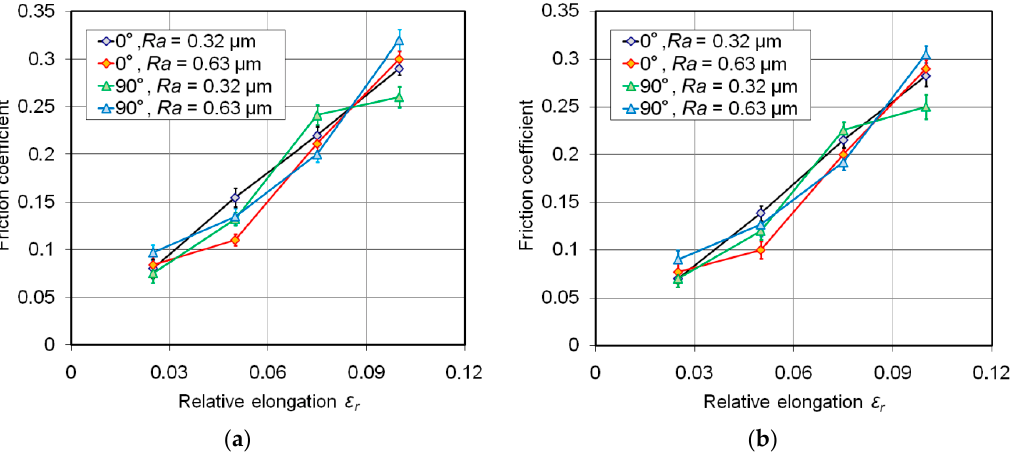
Figure 6. Effect of the relative elongation ε r on the coefficient of friction for ( a ) dry and ( b ) lubricated Figure 6. E ff ect of the relative elongation ε r on the coe ffi cient of friction for ( a ) dry and ( b ) conditions. lubricated